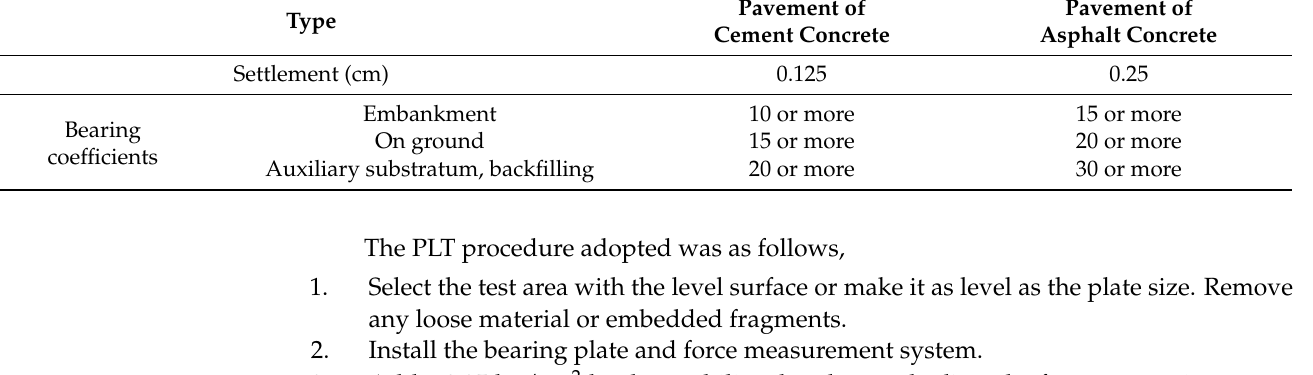
Pavement of Pavement of Cement Concrete Asphalt Concrete